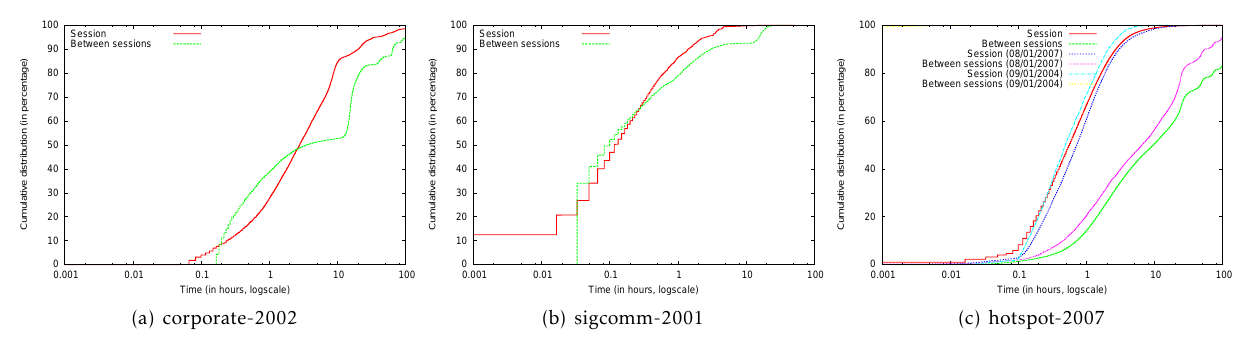
Figure 4. Online availability